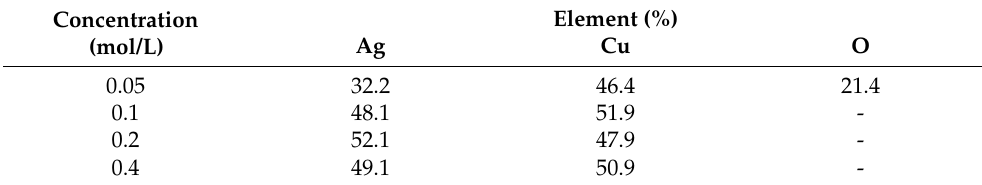
Table 2. EDS results of AgCu nanoparticles produced at different concentrations at 800 ◦ C.